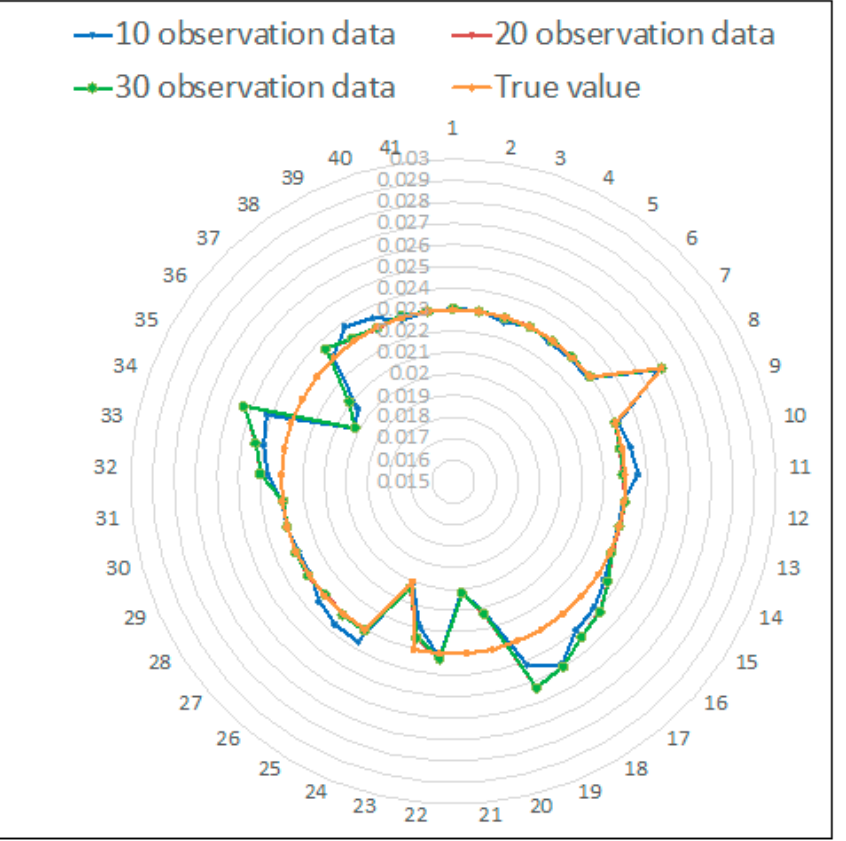
Figure 7. Roughness inversion results at all section nodes with different observational data points.